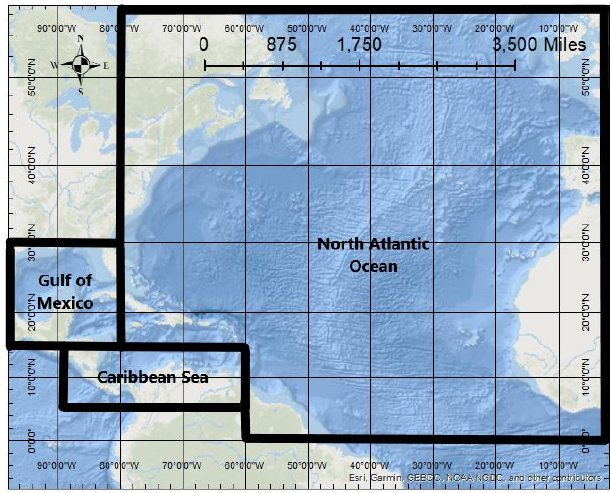
Figure 1. Map depicting study area and divided sub-basins.